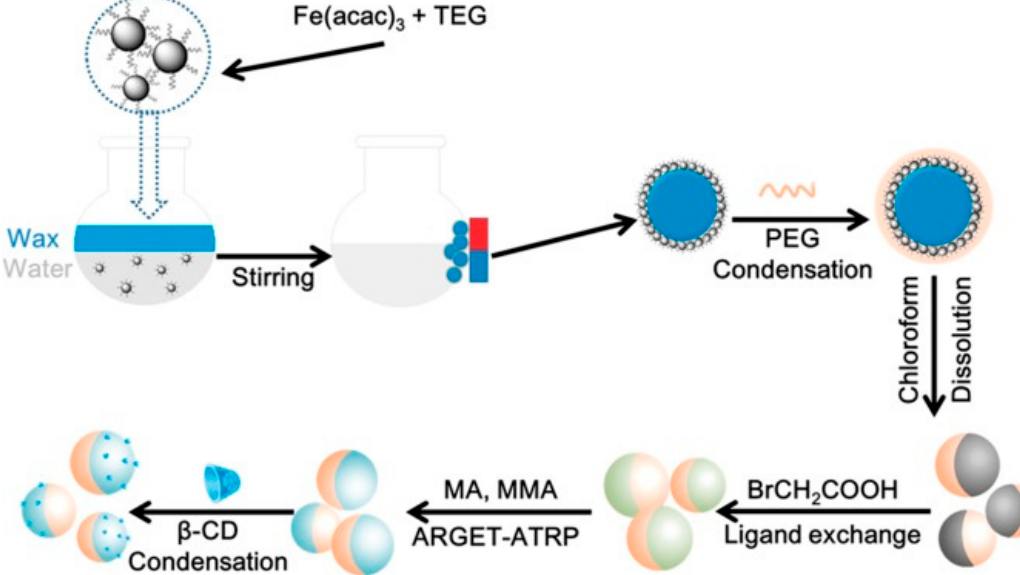
Figure 1. Schematic display of the method for the synthesis of Fe 3 O 4 @AJNPs. Reproduced from Reference [24] with permission.